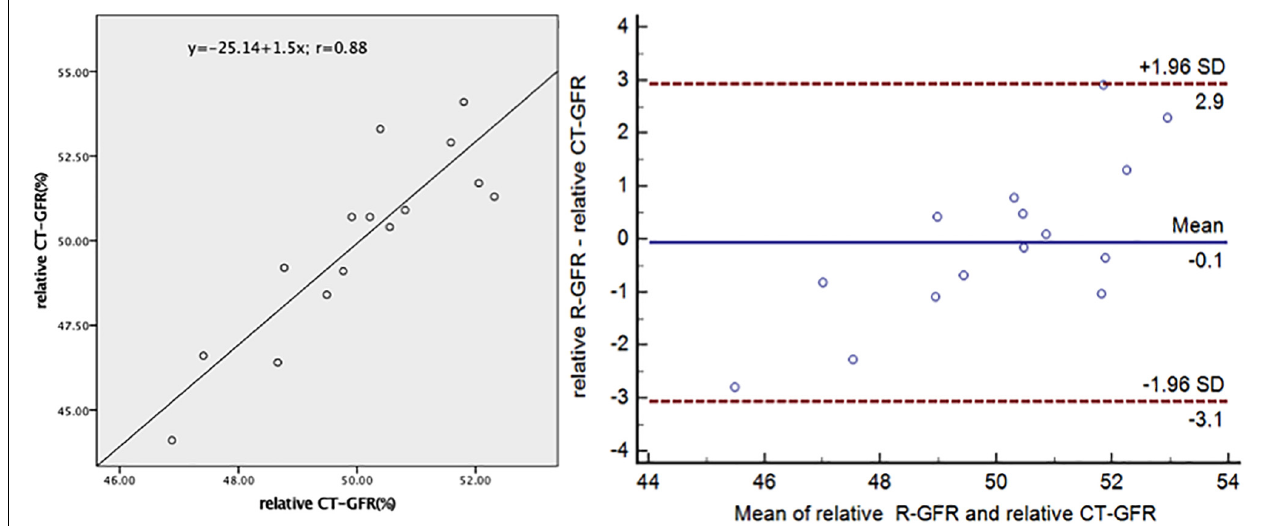
FIGURE 5 | Correlation and concordance between the relative R-GFR and relative CT-GFR of split kidney of non-tumor-bearing in early renal parenchymal phase. CT-GFR, quantitative glomerular filtration rate based on the method of two point of Patlak plot; R-GFR, quantitative glomerular filtration rate based on the radionuclide